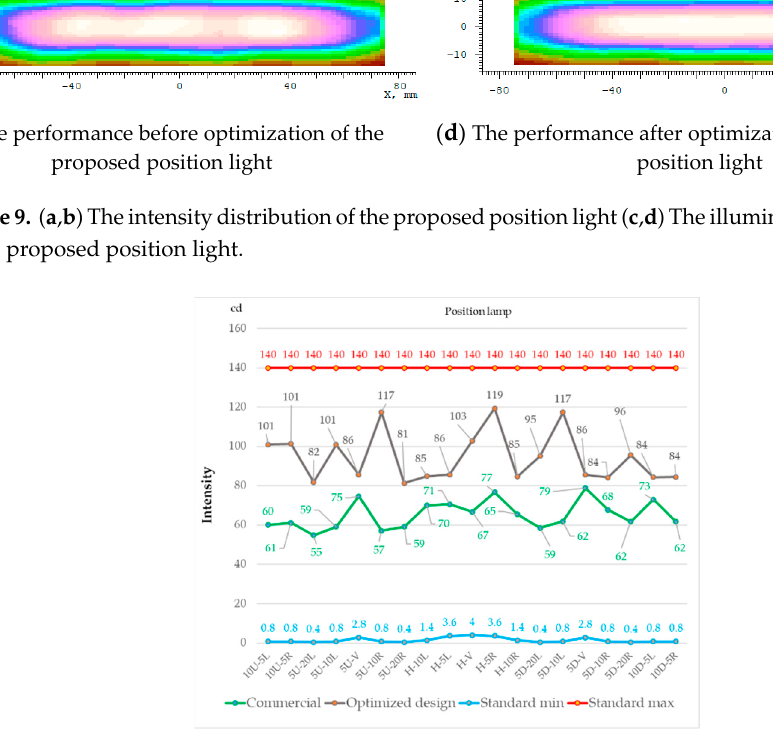
regulation between the new optimized position lamp and the commercial one.